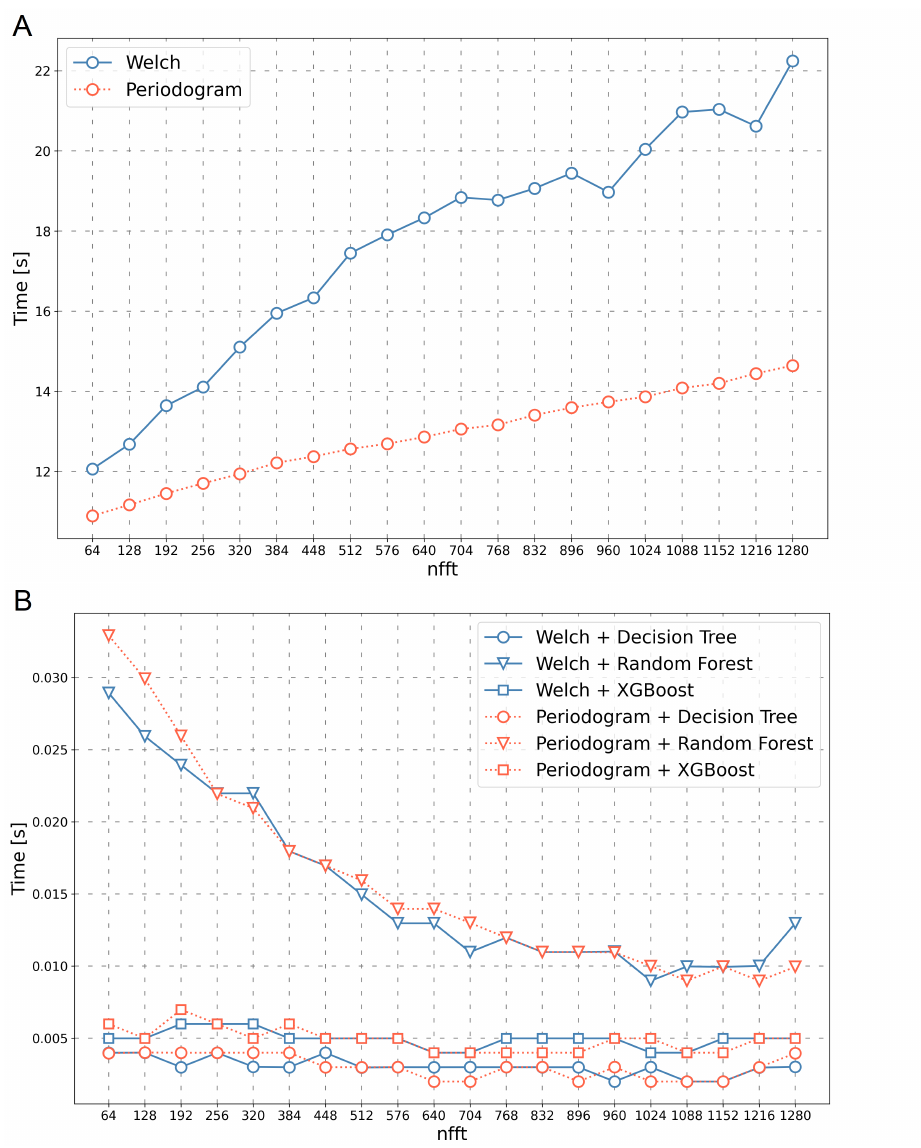
Figure 6. Transformation time ( A ) and classification time ( B ) depending on nf ft values for various transformation methods and